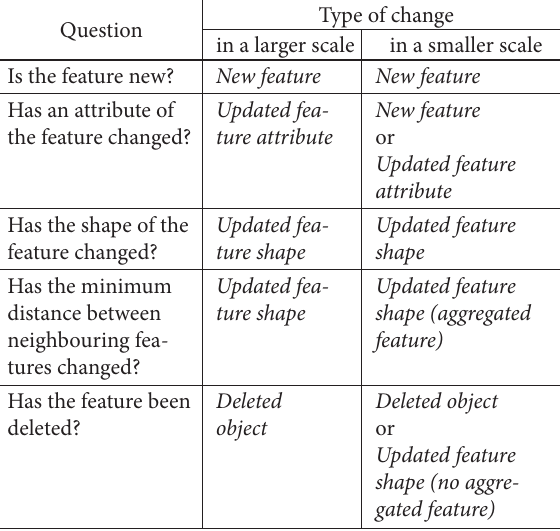
Table 2. Possible types of changes in features